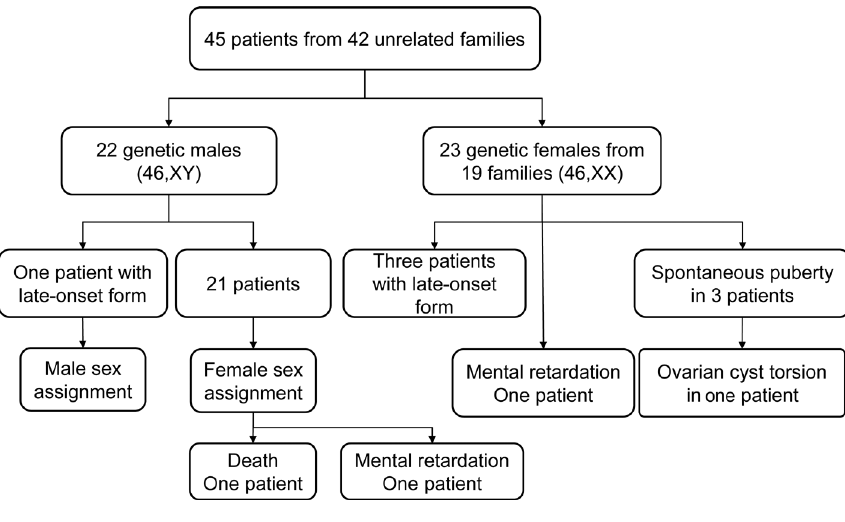
Figure 1. Clinical outcomes of patients with congenital lipoid adrenal hyperplasia. Among the 45 patients, 22 were genetic males and 23 had a 46,XX karyotype. Most patients (41/45, 91.1%) presented with adrenal insufficiency in the neonatal period, while three late-onset patients showed skin hyperpigmentation after the infantile period. Two patients had neurodevelopmental deficits caused by adrenal insufficiency resulting from poor adherence to medication. Three genetic female patients experienced spontaneous females, who were both com- pound heterozygous for p.Q258* and tion and hyponatremia at the age of 1.2 years and 2.8 years, respectively.